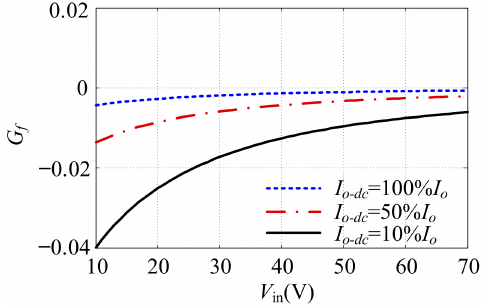
Figure 11. G f as the function of V in at different I o